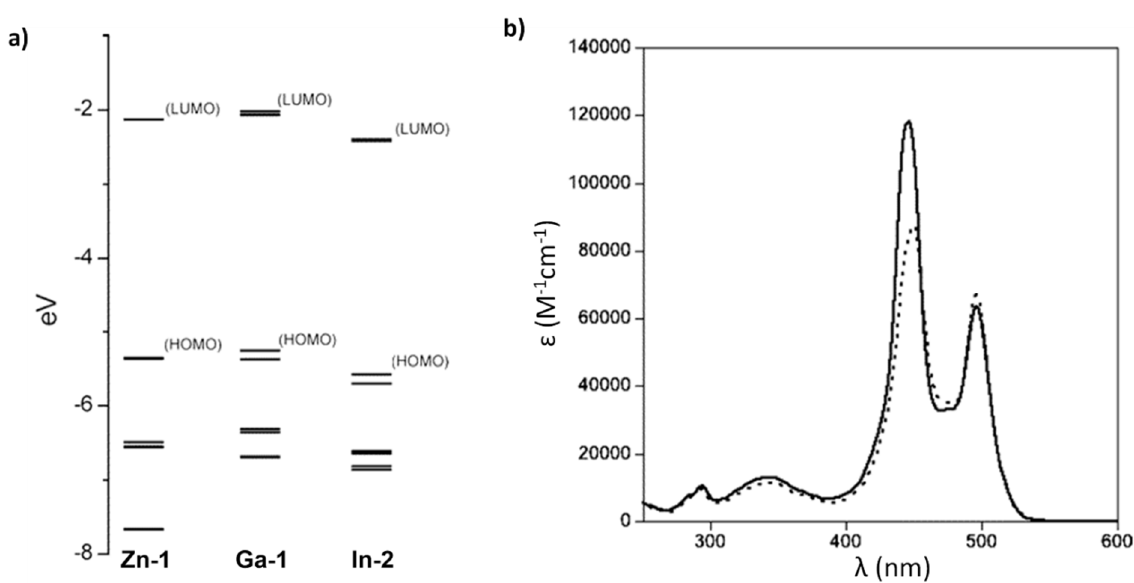
Figure 31. ( a ) Energy level diagrams of Ga-1 , In-2 and Zn-1 obtained with DFT calculations. ( b ) UV- Vis absorption spectra of Ga-2 (dotted line) and In-3 (solid line) in hexanes. Reproduced with permission from [3]. Copyright © 2006 American Chemical Society.